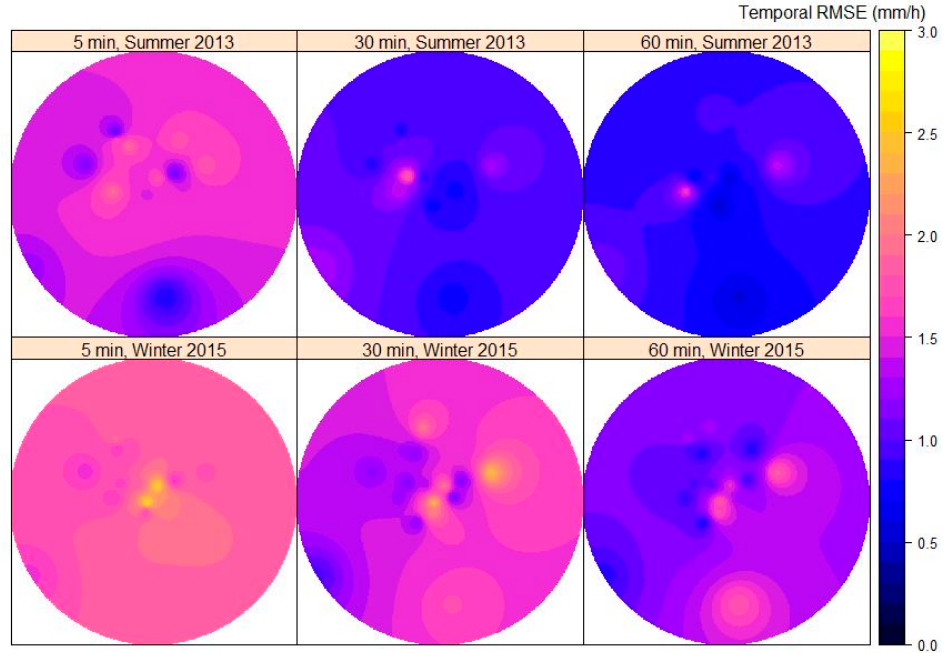
Figure 4. Maps of temporal bias in radar data by season and temporal resolution in mm/h.